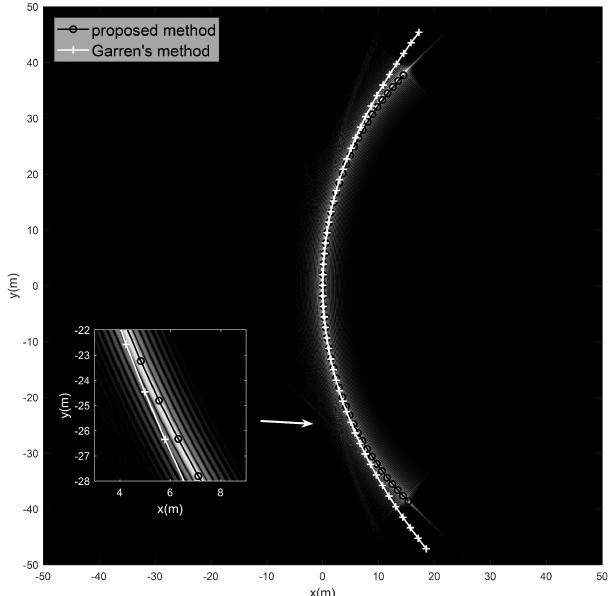
Figure 27. The SAR image superimposed with image traces calculated with linear SAR and CSAR model. The target moved from bottom to top with 2